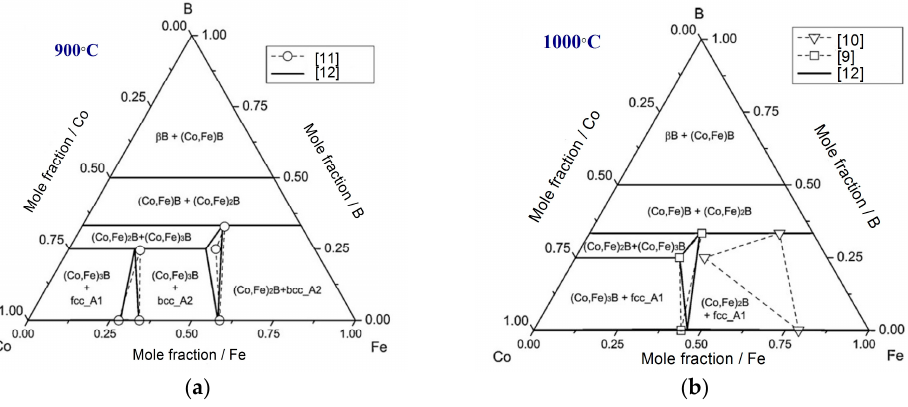
Figure 2. Isothermal section of Co-Fe-B ternary system at ( a ) 900 °C [12]; and ( b ) 1000 °C [12].